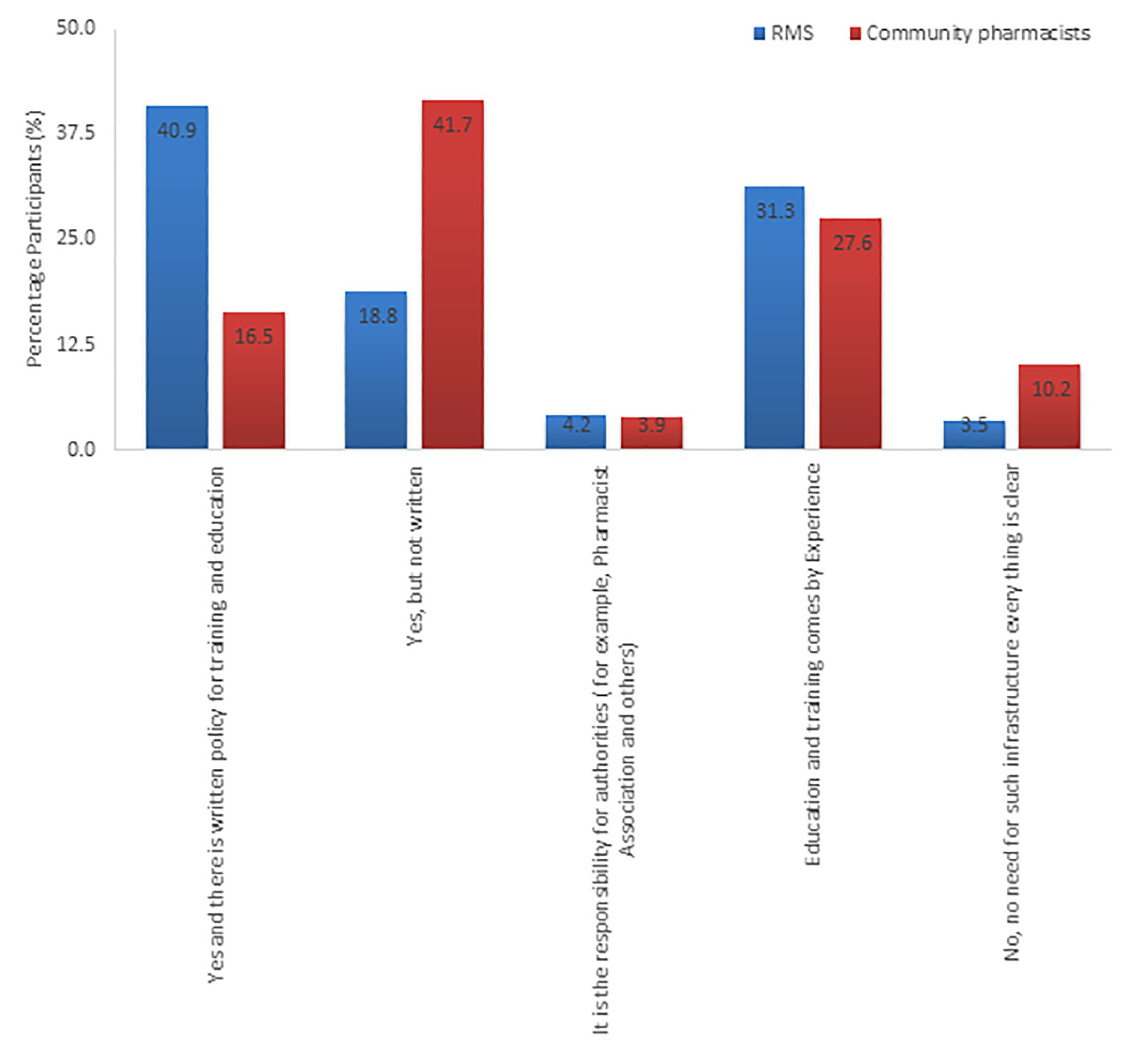
Fig 1. Availability of documented pharmaceutical education and training infrastructure in Royal Medical Services and Community